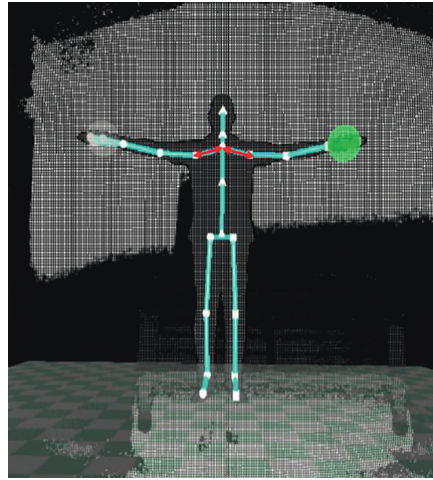
Figure 2: The T-pose.